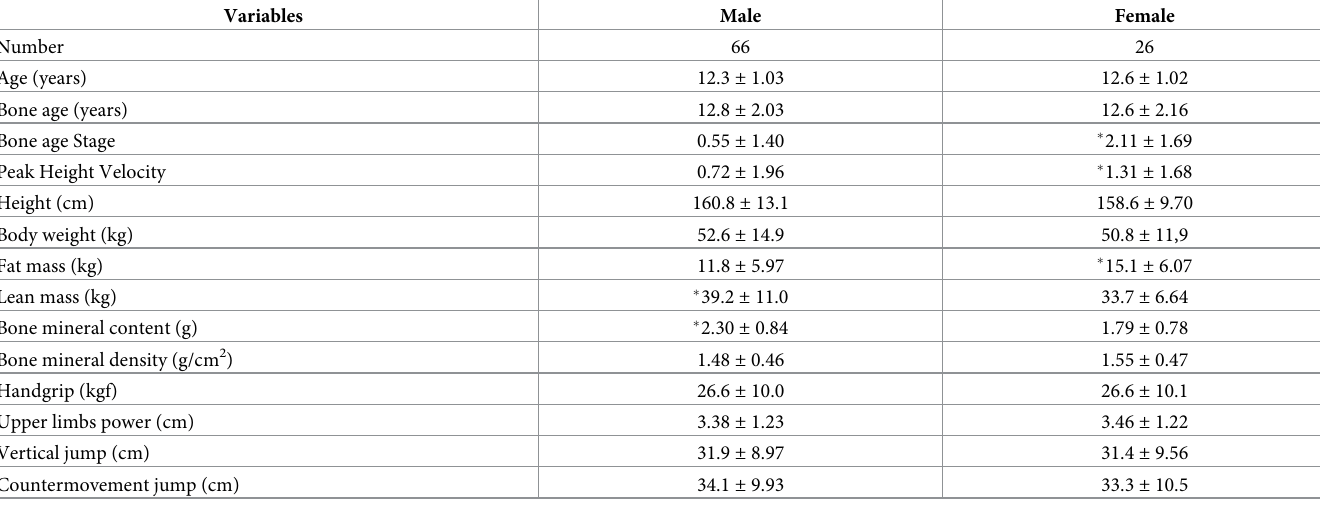
Table 1. Sample characterization in relation to the characteristics of puberty, body morphology and neuromuscular tests.